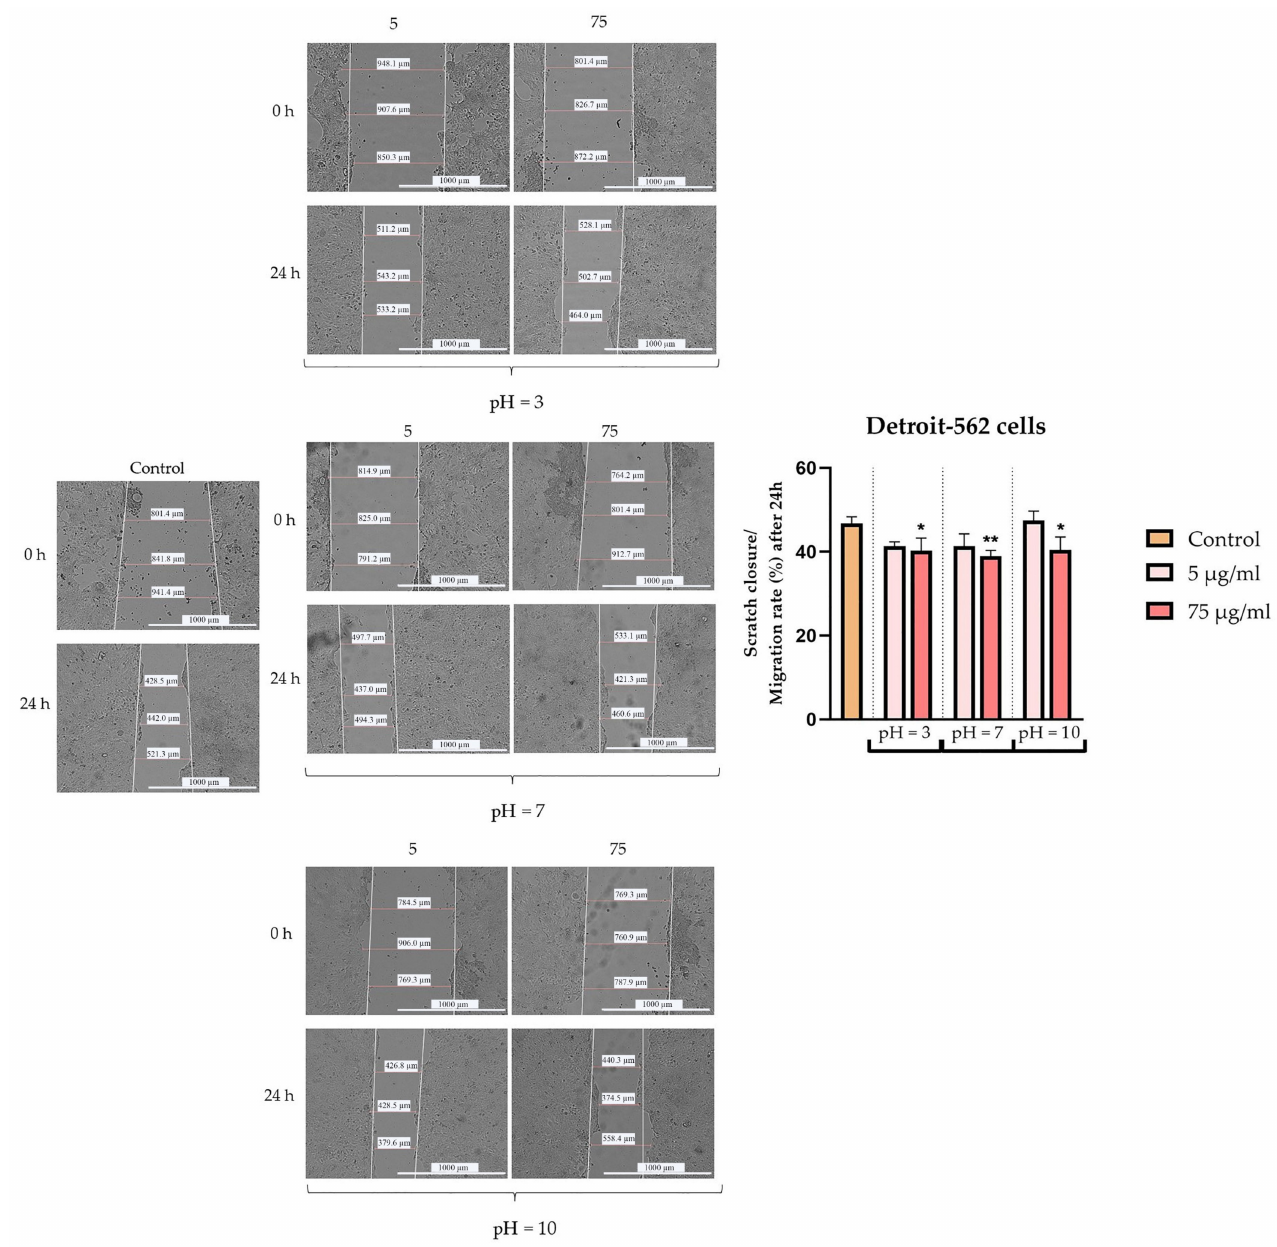
Figure 5. Scratch closure rate of Detroit-562 cells following P1 treatment (5 and 75 µ g/mL) in artificial saliva with three types of pH (acid, neutral, and basic). The bar graphs are presented as wound closure percentage after 24 h compared to the initial surface. The data are expressed as mean values ± SD of three independent experiments performed in triplicate. The statistical differences between the control and the P1-treated groups were identified by applying one-way ANOVA followed by the Dunnett’s multiple comparison post-test (* p < 0.05; ** p <